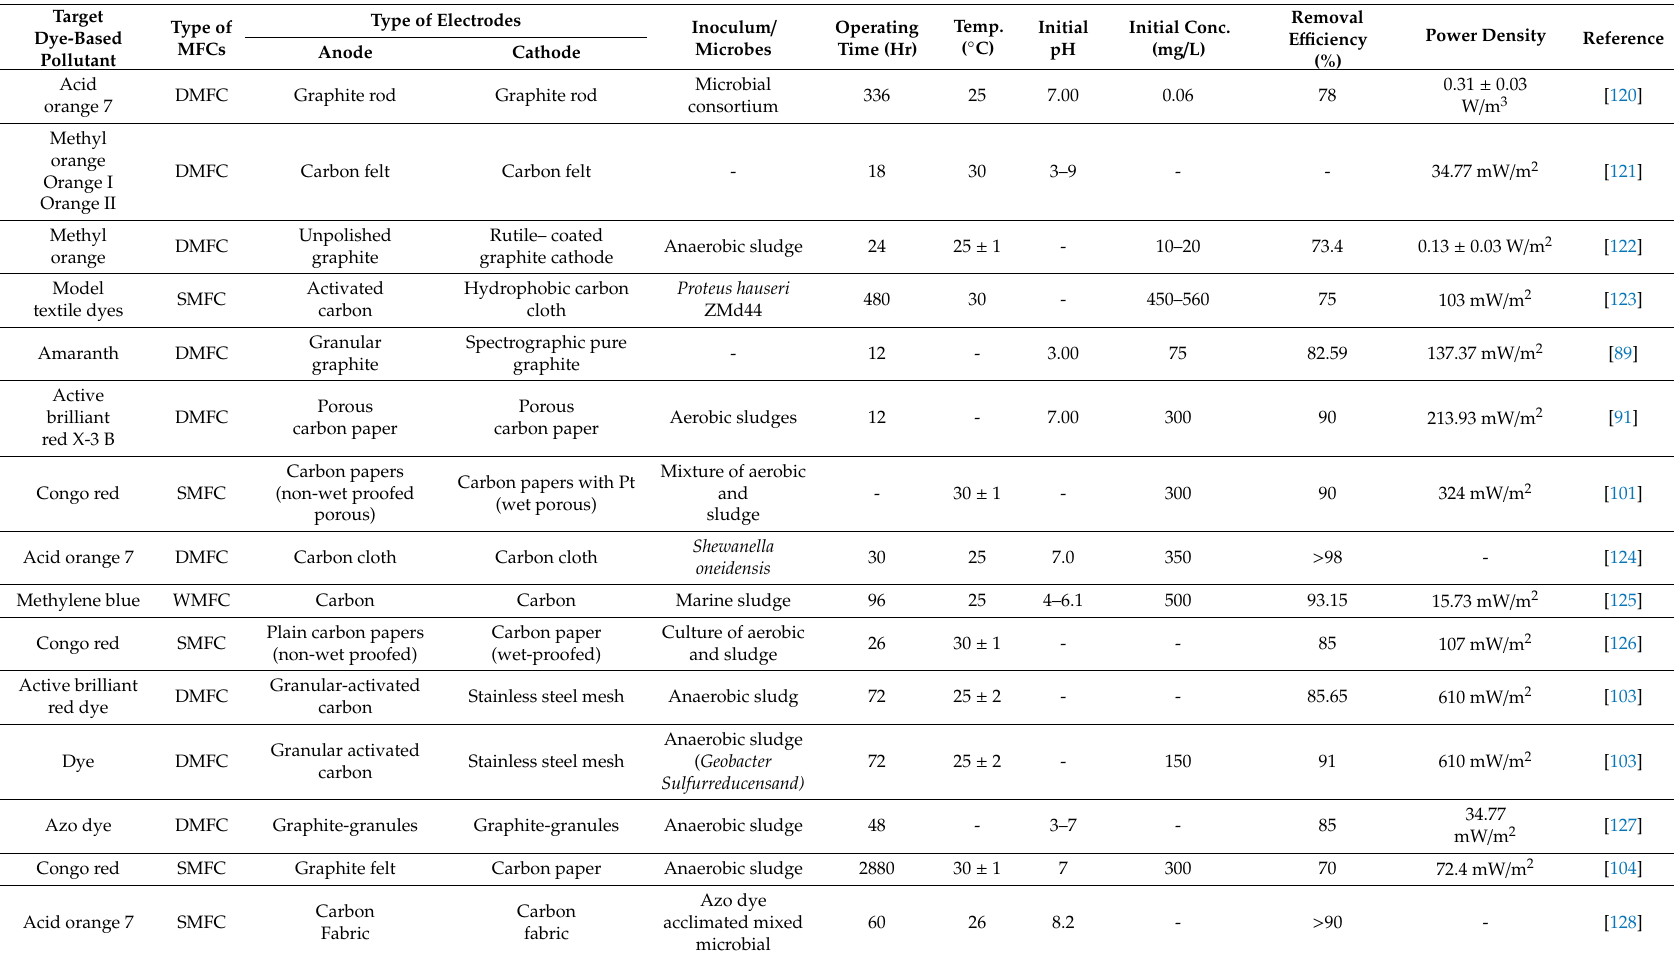
Table 2. List of dye removal e ffi ciency, energy output through